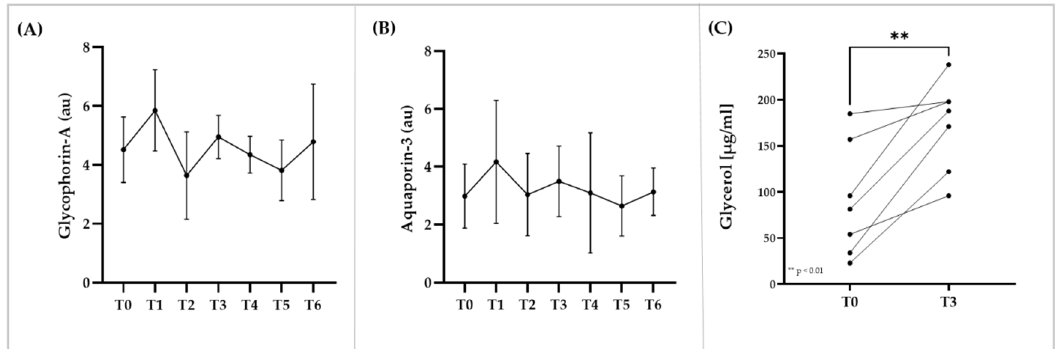
Figure 5. RBC membrane proteins and changes in RBC glycerol concentrations during blood sampling and transfusion. ( A ) Glycophorin-A and ( B ) Aquaporin-3 remained unaffected by the intervention. ( C ) RBC glycerol levels increased from T0 to T3. Data are mean (SD).